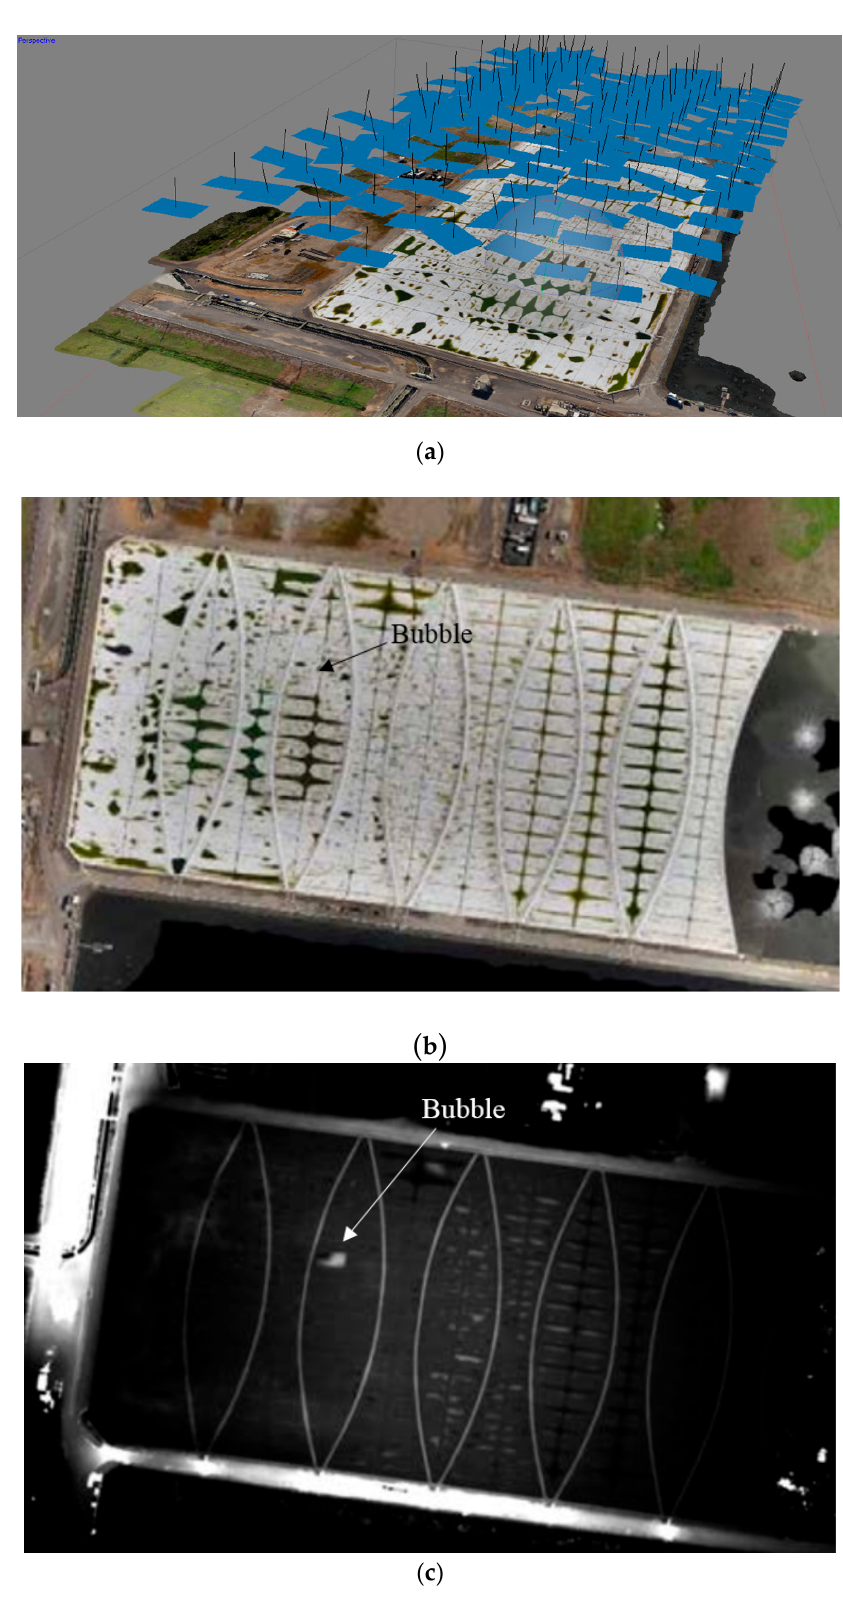
Figure 10. ( a ) Locations where photos were taken (133 photos); ( b ) Orthophoto from images; ( c ) Elevation map of the floating cover.